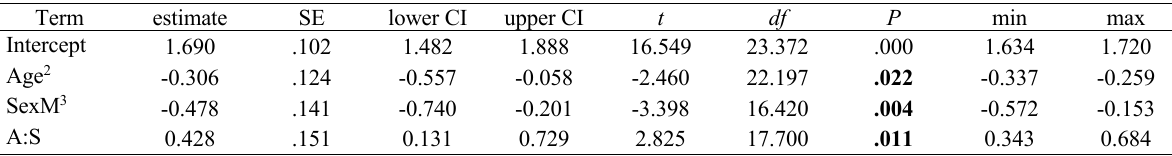
Results of GLMM Model Two of Age, Sex and their Interaction on Log-Time-to-Solve 1